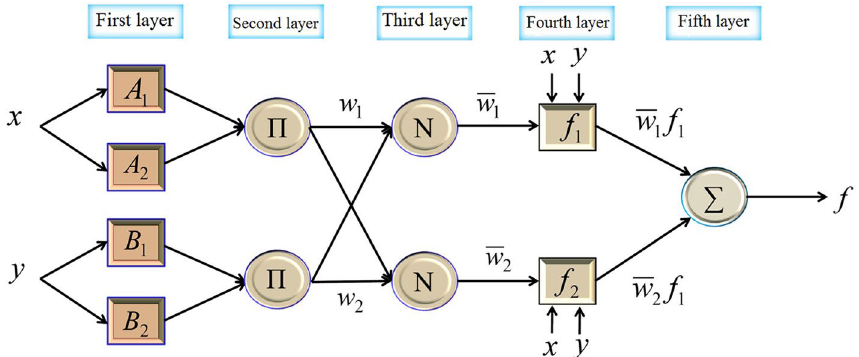
Fig. 1 ANFIS structure for model with two